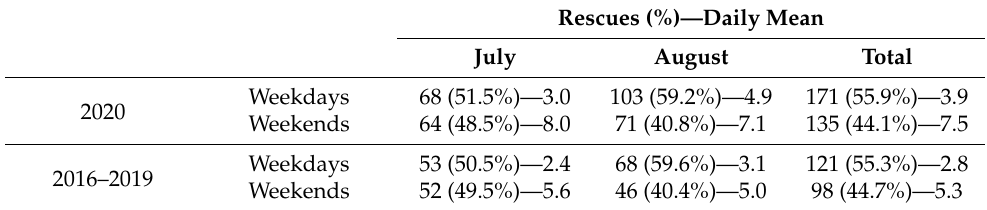
Figure 3. Weekly distribution of rescues from Monday, 29 June and Sunday, 30 August 2020 and equivalent periods for 2016, 2017, 2018, and 2019. Table 3. Frequency and daily mean number of rescues on weekdays and at weekends.